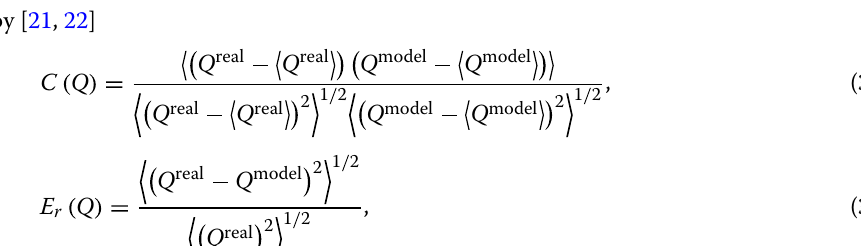
4 h DNS to 64 h DNS . Two evaluation metrics are used to quantify the distinc- tion between the real value ( Q real ) and the modeled value ( Q model ) for targeted variable Q ,